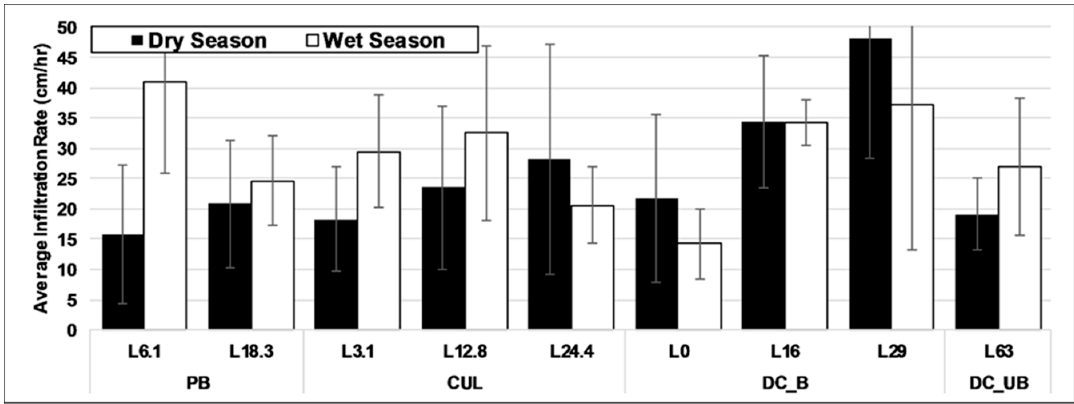
Figure 5. Wet and dry season average infiltration rates (cm / h) for all locations. Standard deviation bars are shown.